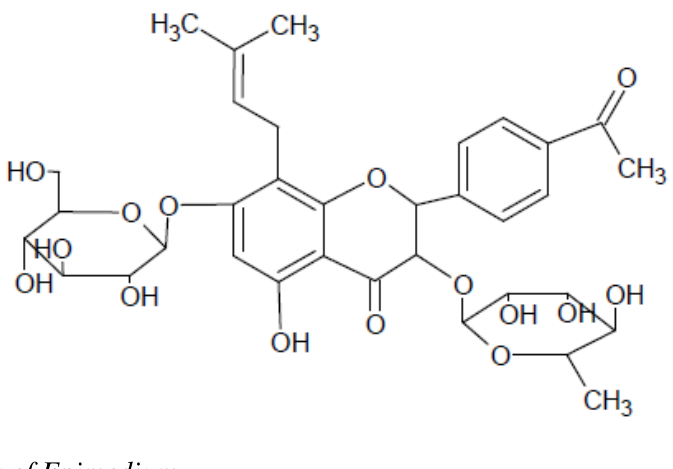
2. Icarrin (2-(4’-methoxyphenyl)-3-rhamnosido-5-hydroxyl-7glucosido-8-(3’-